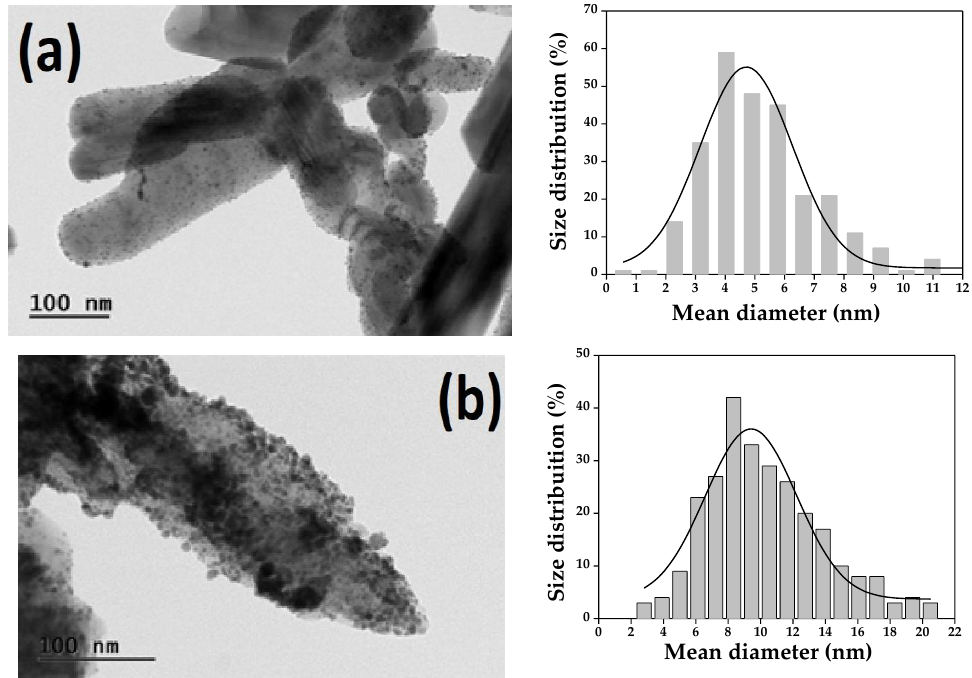
Figure 3. TEM image of ( a ) Au/calc-Sr sup and ( b ) Au/Sr sup . The NPs size distributions are also provided for both materials.